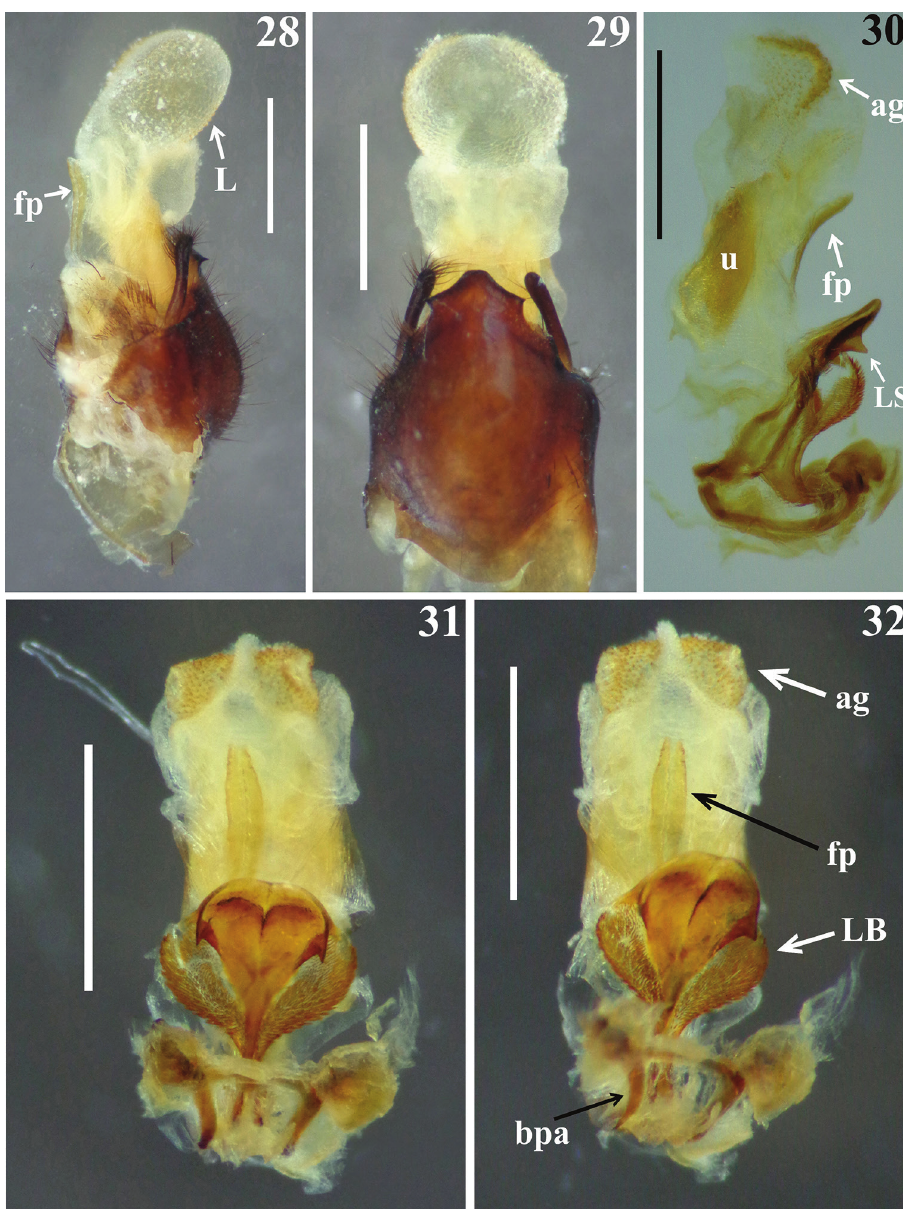
Figures 28–32. Parahiranetis salgadoi Gil-Santana, male genitalia. 28–29 pygophore with endosoma ( ag : apicolateral group of spiny processes of the endosoma; bpa : basal plate arm; fp : pair of elongate, flat processes; L : globe-shaped lobe in distal third of endosoma; LB : large lobe, middle third of the phallothecal plate; LS : lateral large spine of the phallothecal plate; u : U-shaped basal process). Scale bar: 1.0